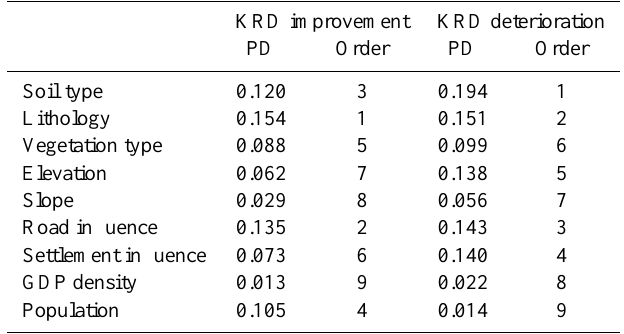
Table 8. PDs of driving data and their order for both the KRD improvement and deterioration.